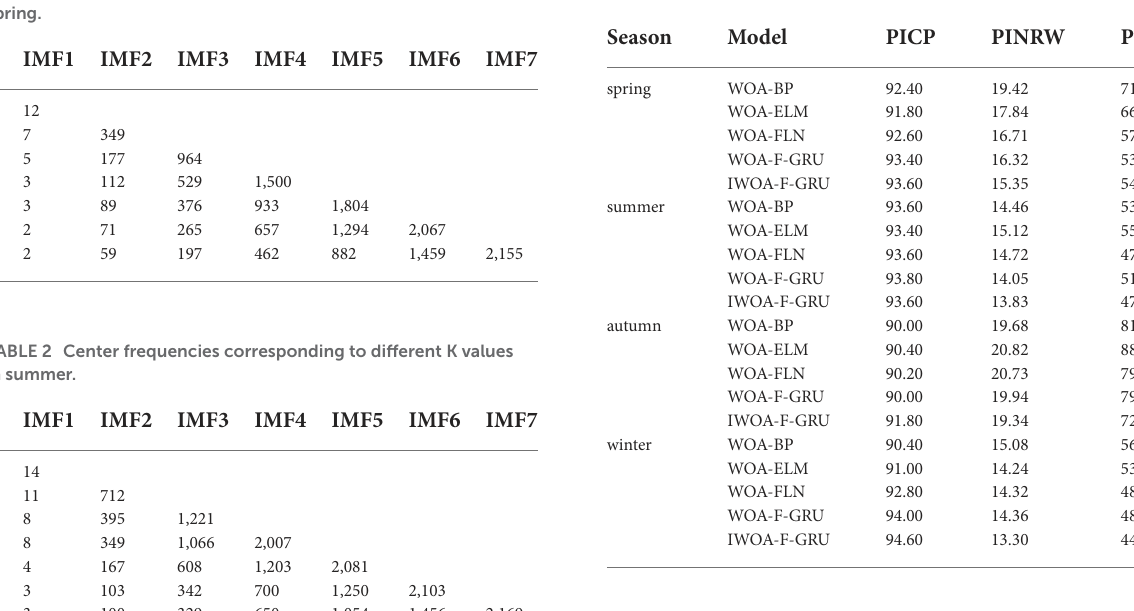
TABLE 5 Evaluation index of four network models in test dataset.